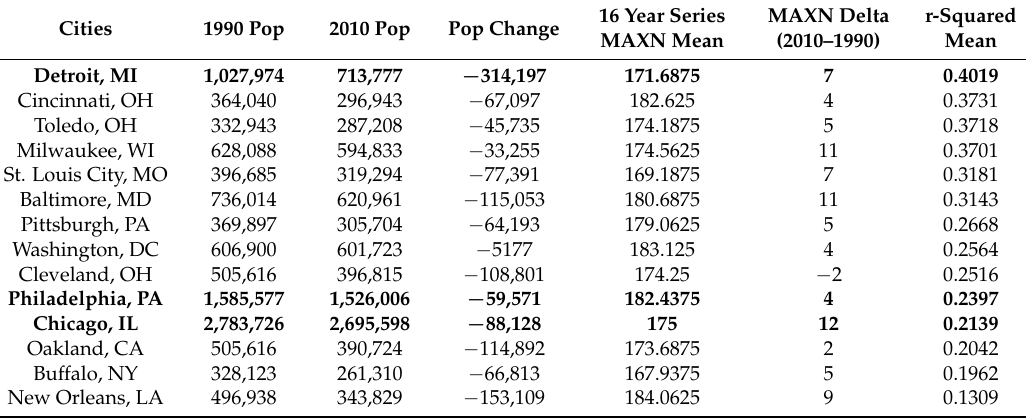
Table 2. Regression relations of time series 16 year Maximum Normalized Difference Vegetation Index, MAXN Delta (regression coefficient for the time variable showing trend in NDVI), and descriptive statistics of r-squared for 14 Shrinking Cities. We selected three cities Chicago, Detroit, and Philadelphia that were one standard deviation above the overall r-squared mean and one standard deviation below the overall r-squared mean, to show cities that were different from the typical cities. The cities had a low, typical, and high, 16-year series r-squared mean.